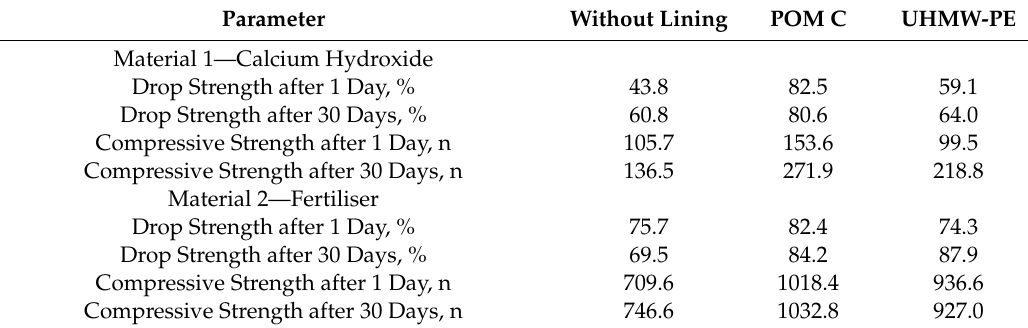
Table 3. Results of sample surface roughness